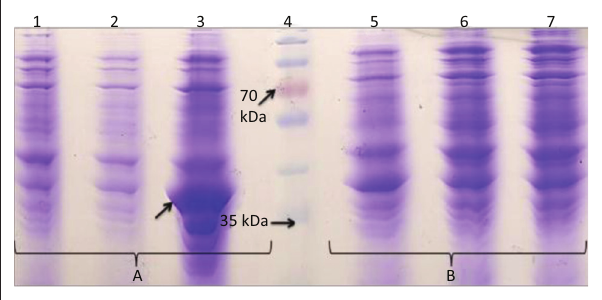
FIGURE 1: Comparison of beta toxin expression in (A) Escherichia coli /Rosetta TM / pET22 β and (B) Escherichia coli /BL21/pET22 β